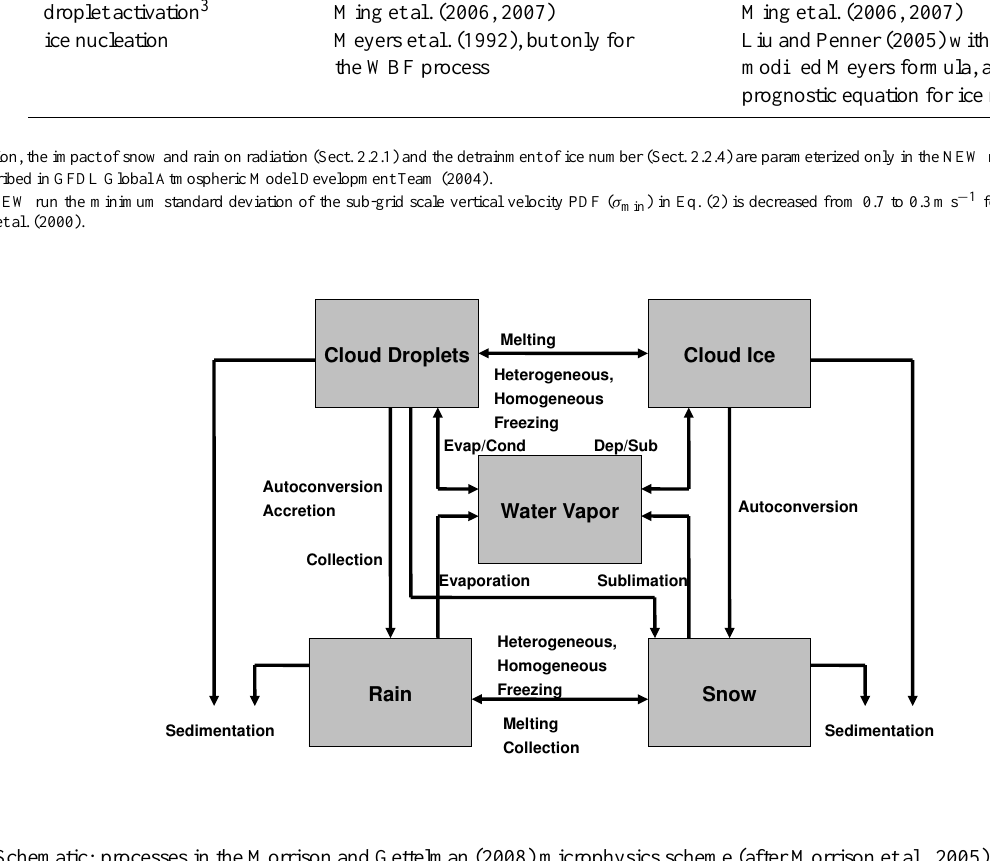
using Eqs. (1) and (2), but the minimum standard deviation of the vertical velocity PDF in Eq. (2) is decreased from